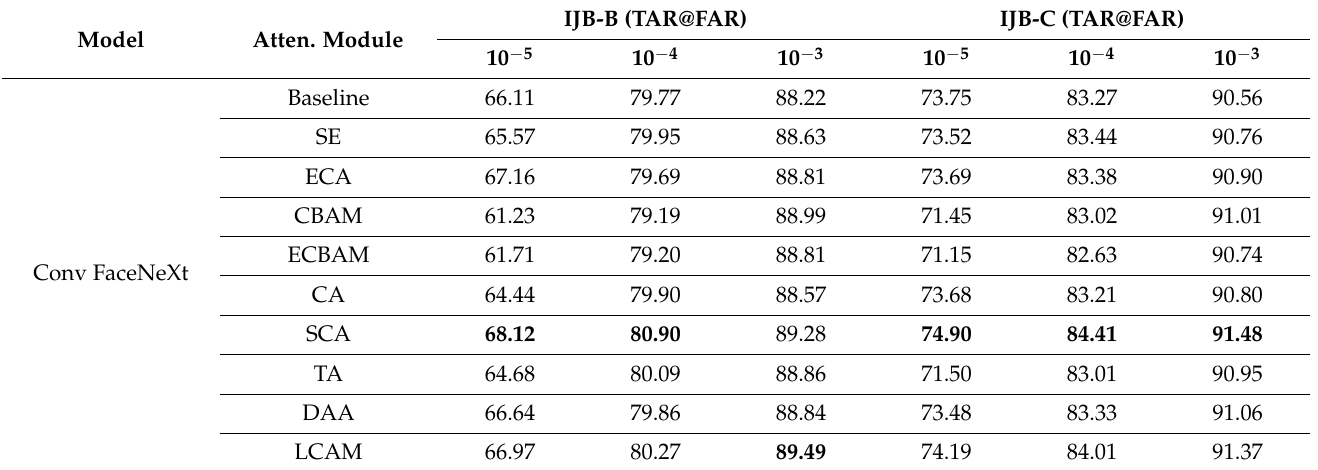
Table 8. Verification accuracy of ConvFaceNeXt for IJB-B and IJB-C datasets. (Bold values are the highest obtained values by the methods).